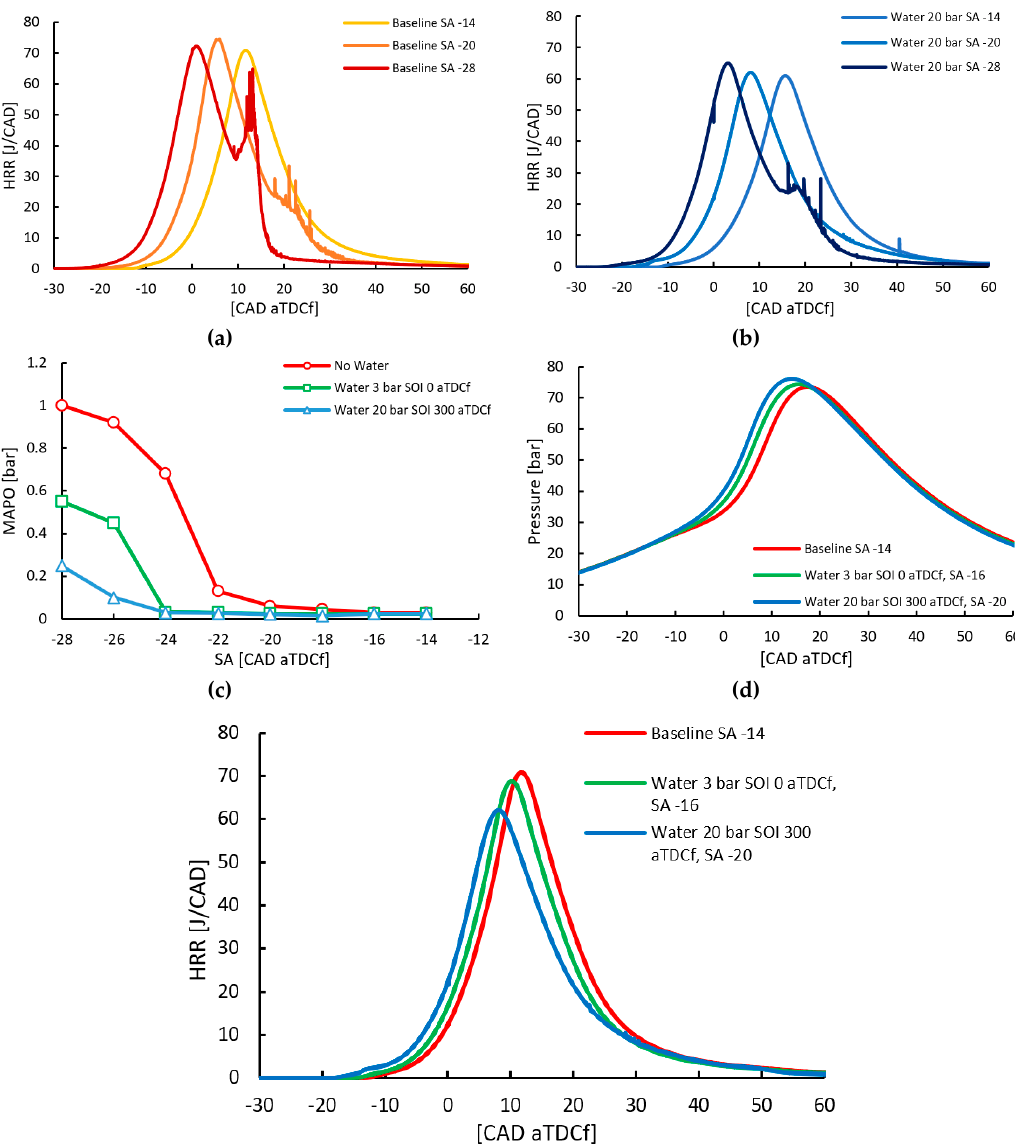
Figure 13. Effect of spark timing variation. Heat release rates for the baseline case w/o water ( a ) and for the case with water at 20 bar ( b ). MAPO vs. SA at 3 bar SOI = 0 CAD and at 20 bar SOI = 300 CAD aTDCf ( c ). In-cylinder pressure curves ( d ) and heat release rates ( e ), with and w/o water, under the same knock margin.